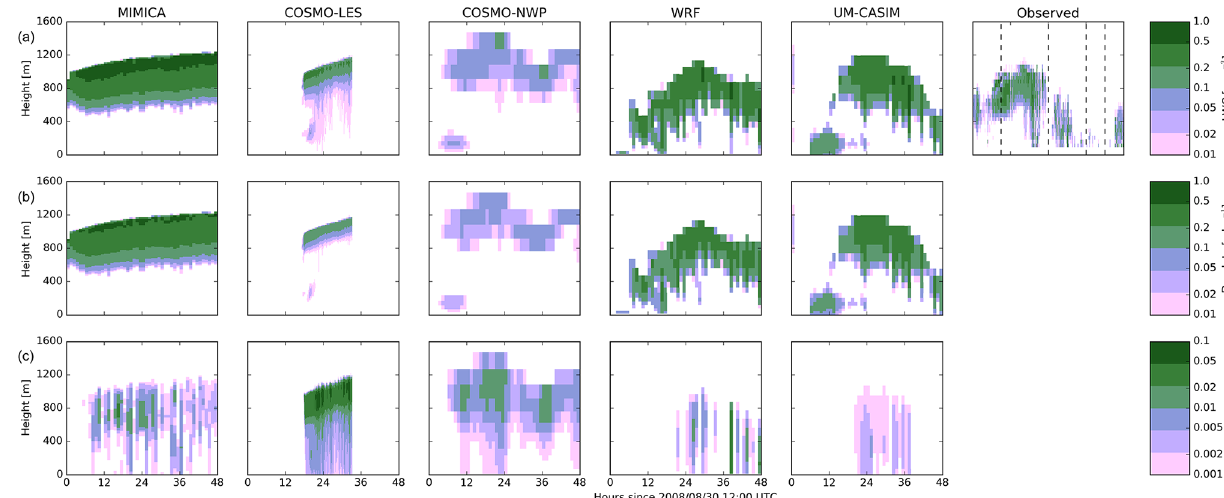
Figure 3. Liquid water content and cloud droplet and rain mass mixing ratios in the simulations with the following: a prescribed CDNC of 30cm − 3 and no cloud ice permitted (CDNC30_NOICE); and liquid water content derived from observations. (a) Liquid water content. (b) Mass mixing ratios of cloud droplets. (c) Mass mixing ratios of rain. Results are shown (from left to right) from the MIMICA, COSMO- LES, COSMO-NWP, WRF, and UM-CASIM models. Observed liquid water contents are shown in the rightmost column. Vertical dashed lines indicate the beginnings and endings of the cloudy and nearly cloud-free